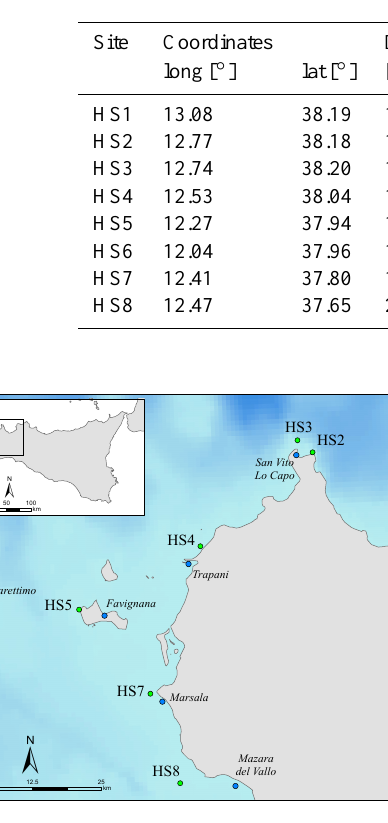
Table 3. Sites selected in proximity of the Sicilian coast. For each site the table shows the geographical coordinates, the depth, the annual average wave power, the annual average wave energy, the distance between the sites and the coast D c , the distance between the sites and the nearest port D p , and the name of the port.